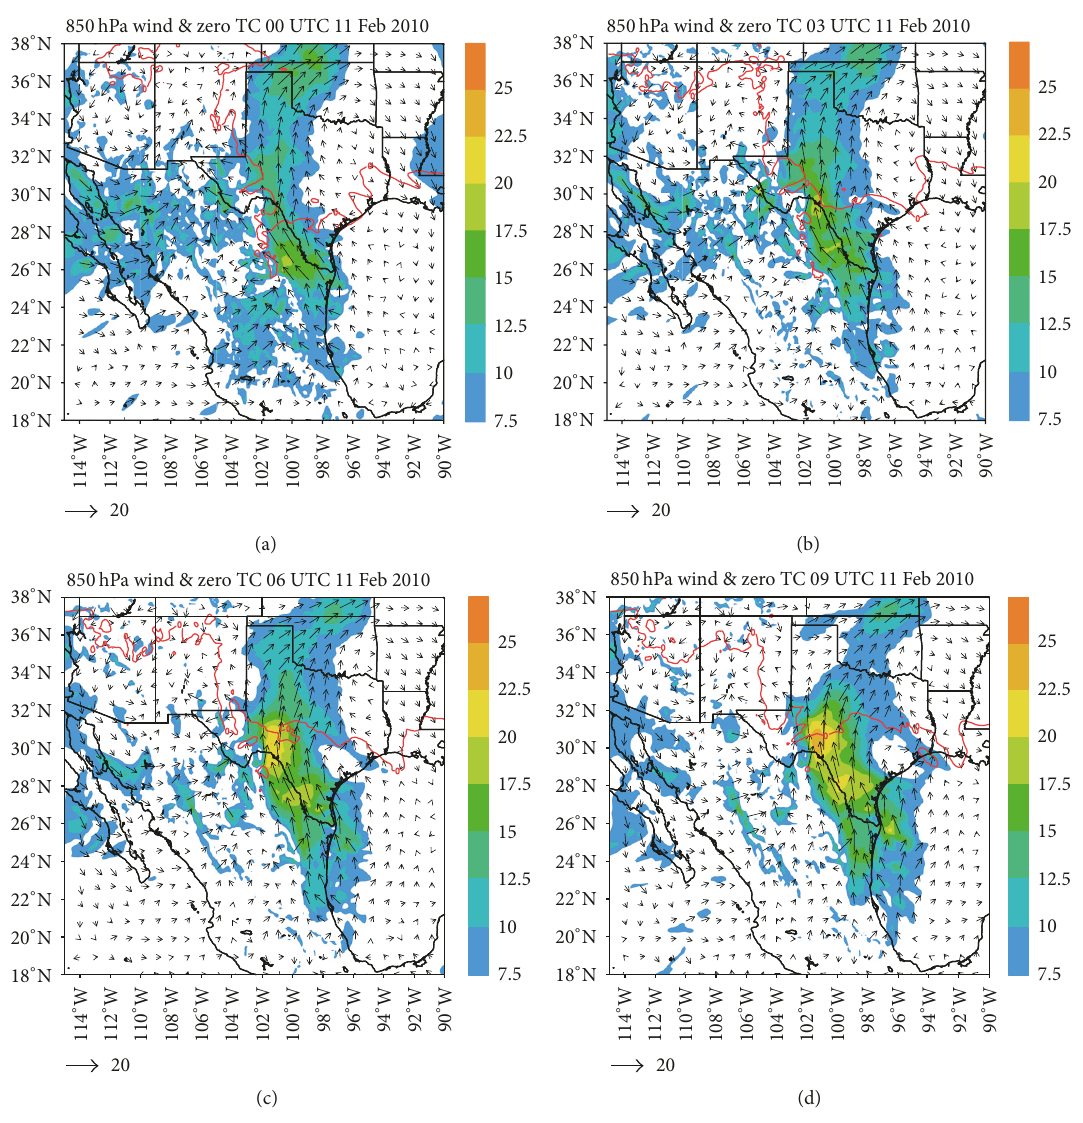
Figure 12: Simulated (12 km) 850 hPa wind (m s −1 ) and 0 ∘ C (273.15 K) temperature contour on (a) 0000, (b) 0300, (c) 0600, and (d) 0900 UTC 11 February